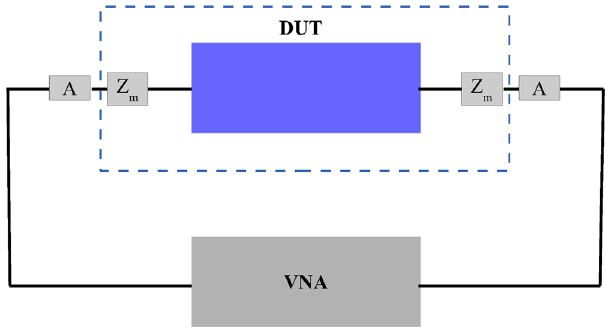
FIG. 11. Stretched wire setup: a singlewire isstretched along the device under test (DUT). The impedance matching is ensured by the network (block “ Z m ” ) and the series attenuator (block “ A ” ).